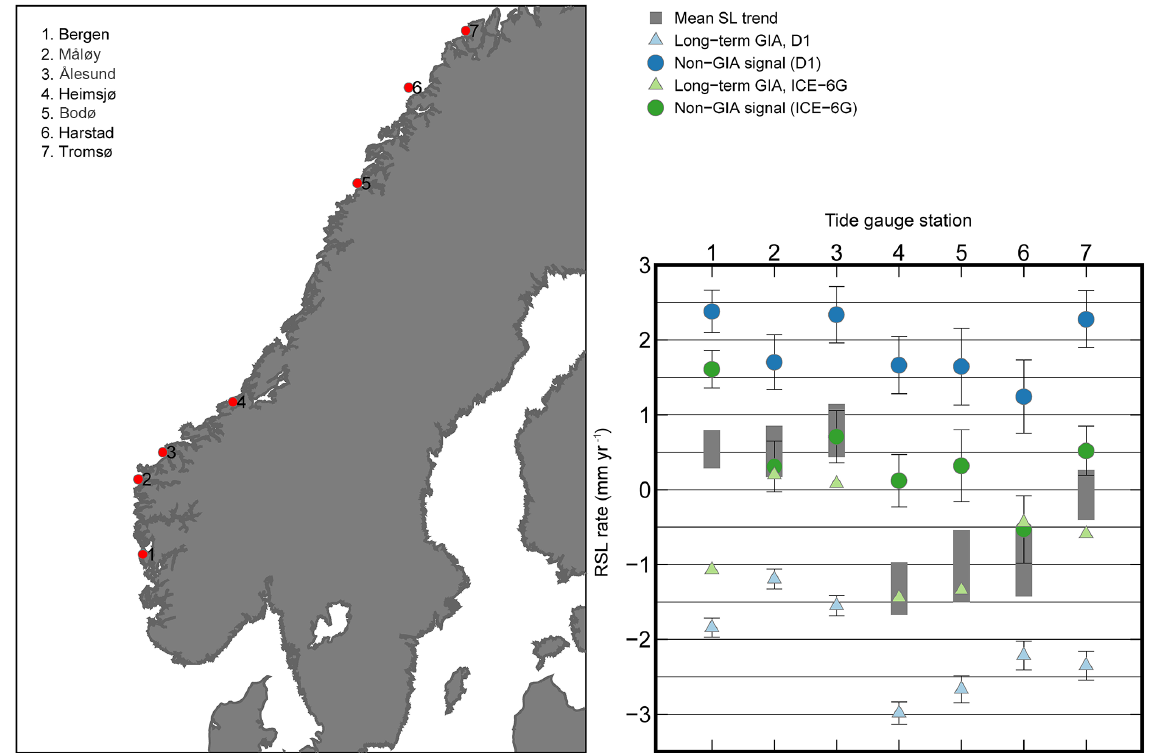
Figure 12. Same as caption for Fig. 11, except for tide gauge locations along the Norwegian